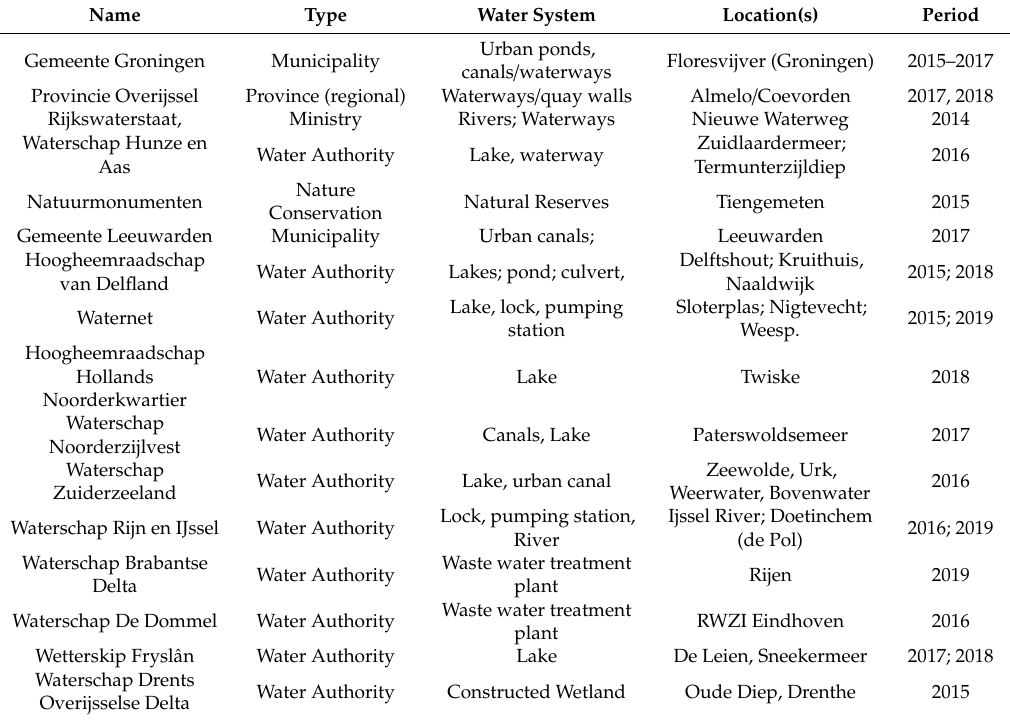
Table 3. List of participating water authorities and other